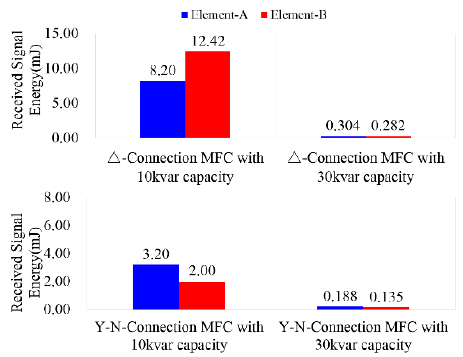
Figure 13. Received signal energy values of Δ -connection and Y-N-connection MFCs with different values of reactive power.